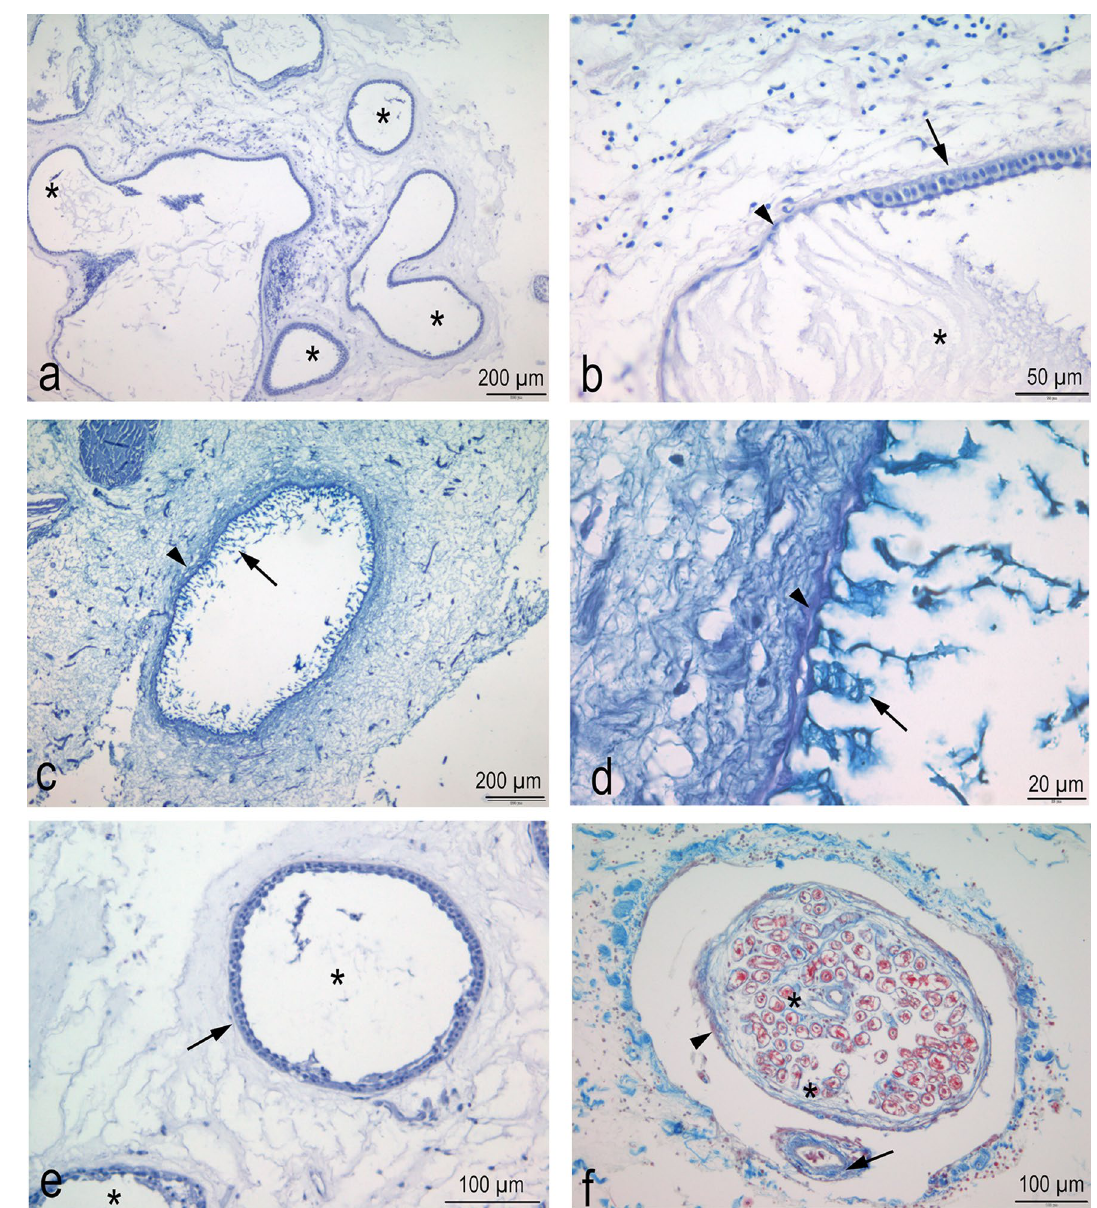
Figure 7. Histological sections of ampullary electroreceptors of C. monstrosa . ( a ) Hematoxylin–Eosin staining. A loose connective tissue surrounds the canal and the chambers (asterisks). ( b ) Hematoxylin–Eosin staining. The sensory epithelium (arrow) is thicker than the epithelium of the canal (arrowhead) and the border between the two type of epithelium is made up few cells with an intermediate morphology. Although not stained, the gel substance, secreted by the canal lining cells, is visible (asterisk). ( c , d ) Alcian-PAS staining. The canal epithelium (arrowheads) secretes an Alcian-positive substance (arrows) in the canal lumen. ( e ) Hematoxylin–Eosin staining. Alveoli (asterisk) are lined up by a sensory epithelium (arrow). ( f ) Masson’s trichrome staining. In the connective tissue surrounding the Ampullae, the nerve fibers are visible. They are enveloped in perineurium (arrowhead) and run along with blood vessels (arrow). Each axon is enveloped in endoneurium